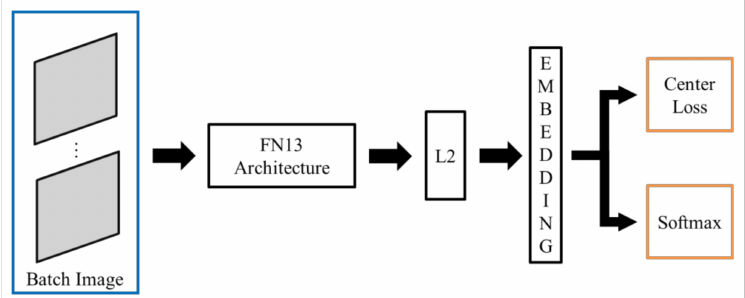
Figure 4. Block diagram of FN13 architecture using center loss